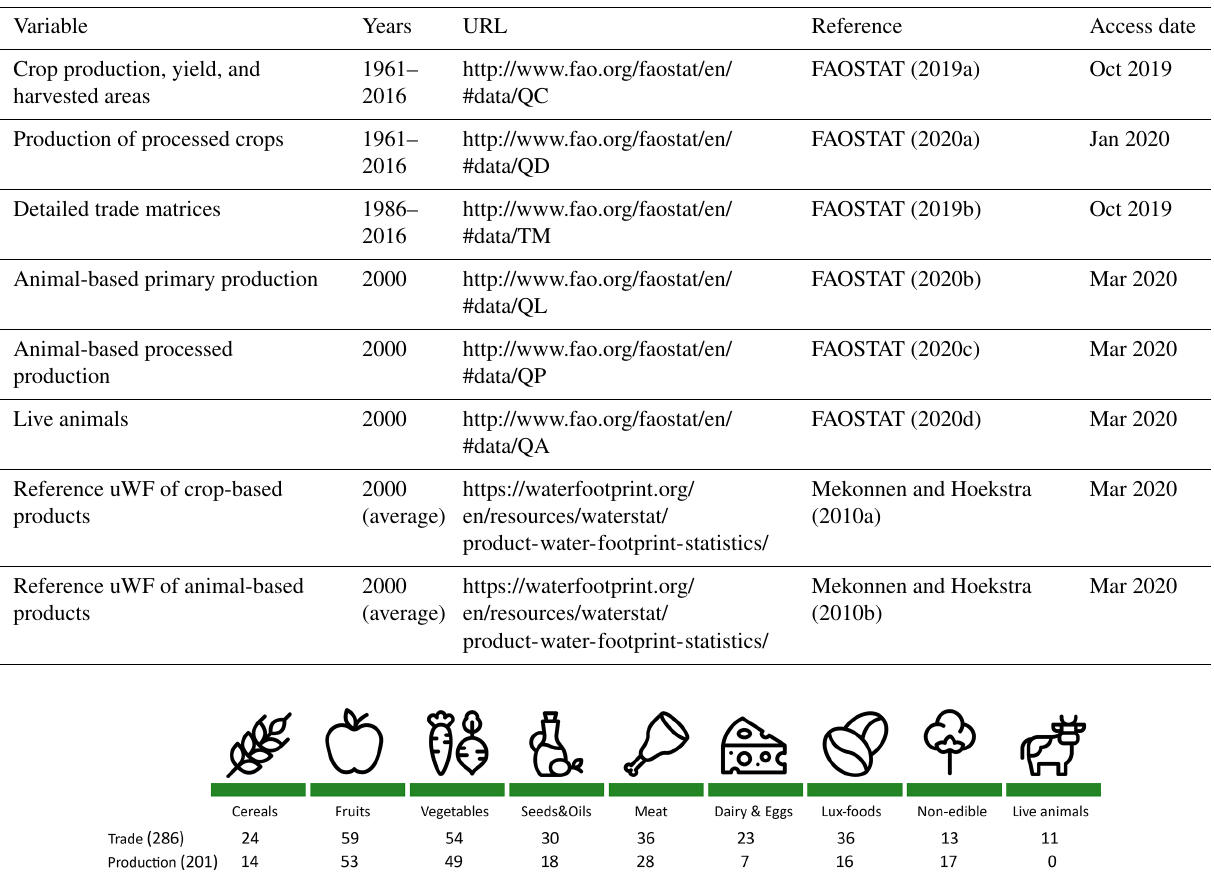
Table 1. Data sources used to prepare the CWASI database.